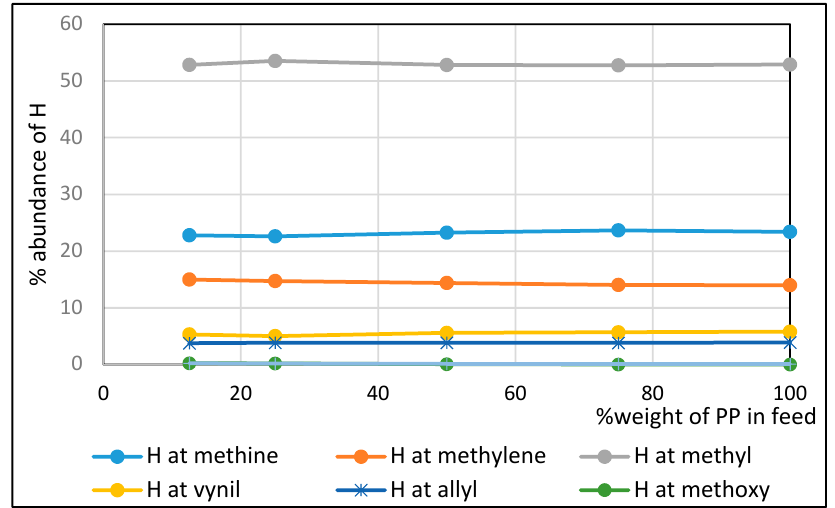
Figure 11. Effect of % weight of PP in feed mixture on %amount of H in non-polar fraction of bio-oil. Figure 11. E ff ect of % weight of PP in feed mixture on %amount of H in non-polar fraction of